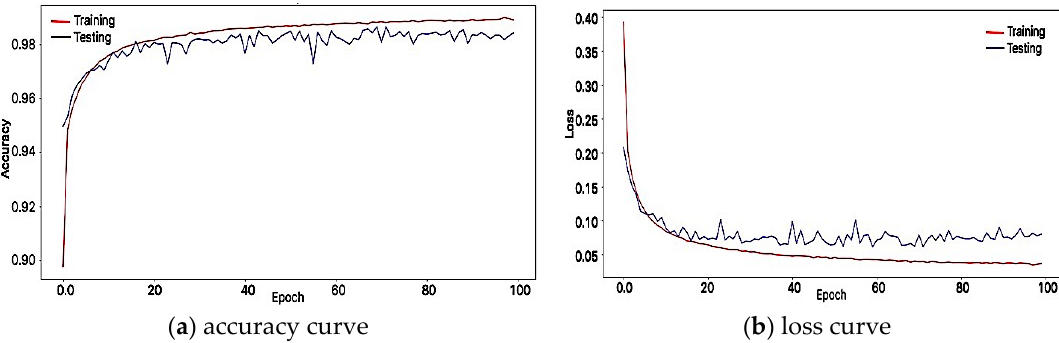
Figure 5. Training and testing evaluation.